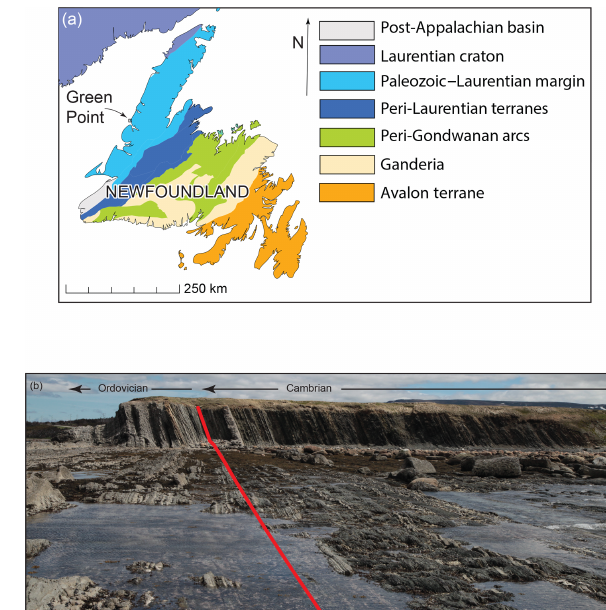
Figure 1. (a) Main tectonic subdivisions of Newfoundland, show- ing the location of Green Point stratotype (based on Lacombe et al., 2019). Coastline made with Natural Earth Data: free vector and raster map data at http://naturalearthdata.com/ (last access: 17 February 2020). (b) View of the cliff at Green Point, Gros Morne National Park, Newfoundland, Canada, at low tide. Red line indi- cates Cambrian–Ordovician boundary (middle of bed 23), as de- fined by Cooper et al.